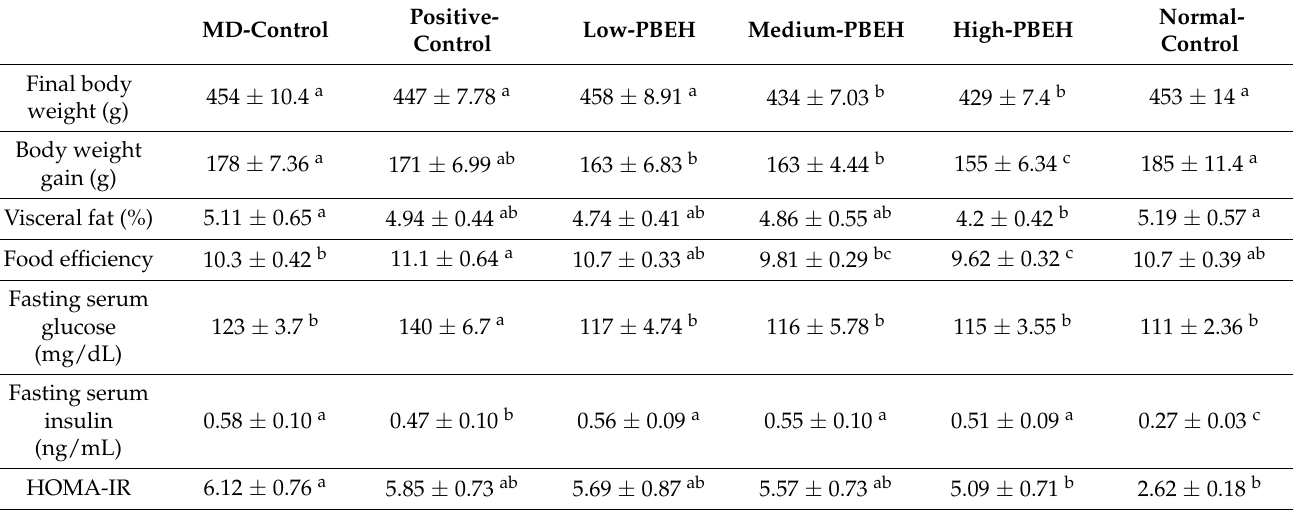
Table 2. Body weight and glucose metabolism at the end of experimental